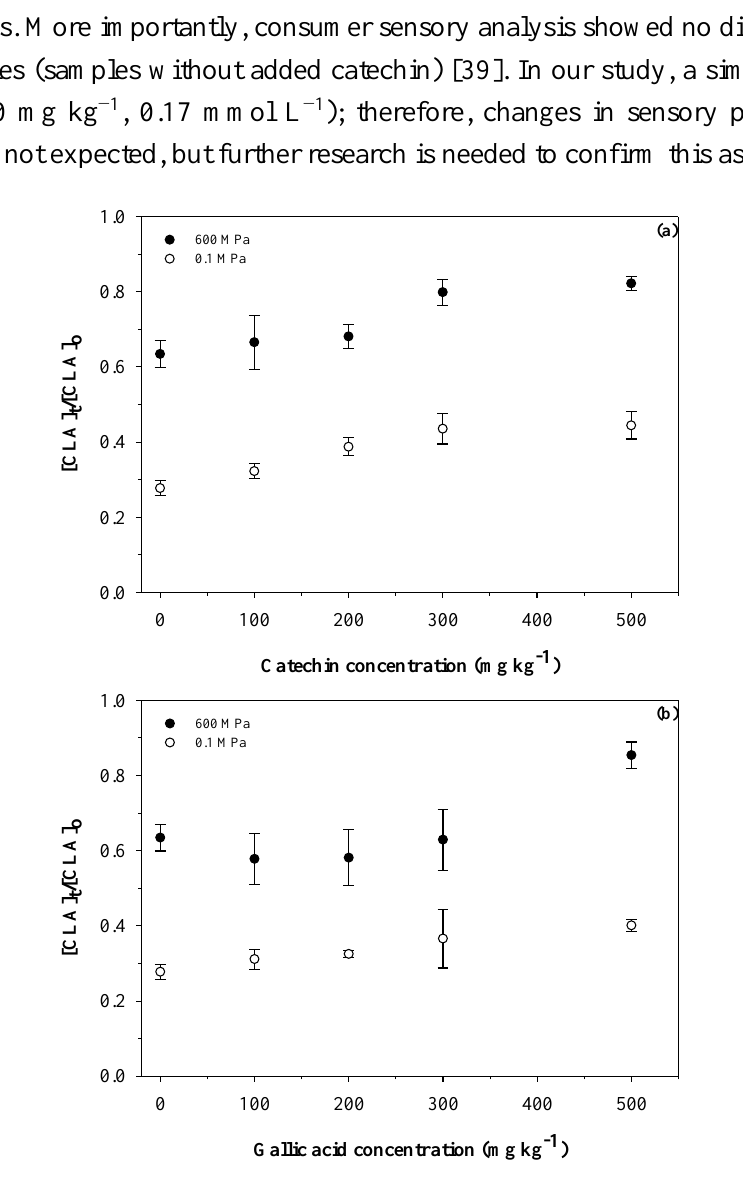
Figure 3. Effect of the concentration of ( a ) catechin and ( b ) gallic acid on the CLA retention in CLA-enriched milk treated at 120 °C for 15 min at either 0.1 or 600